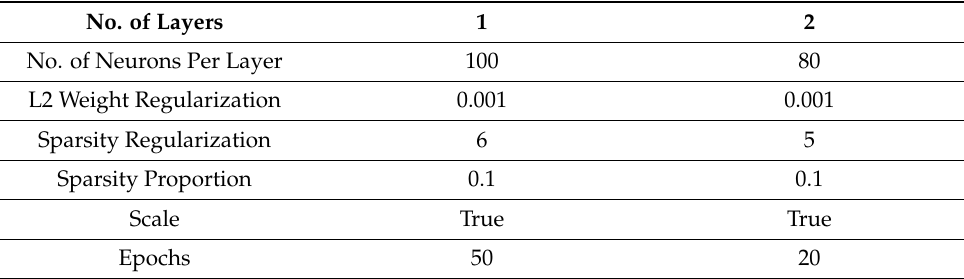
Table 1. Parameter values of Sparse Auto encoder used in the proposed